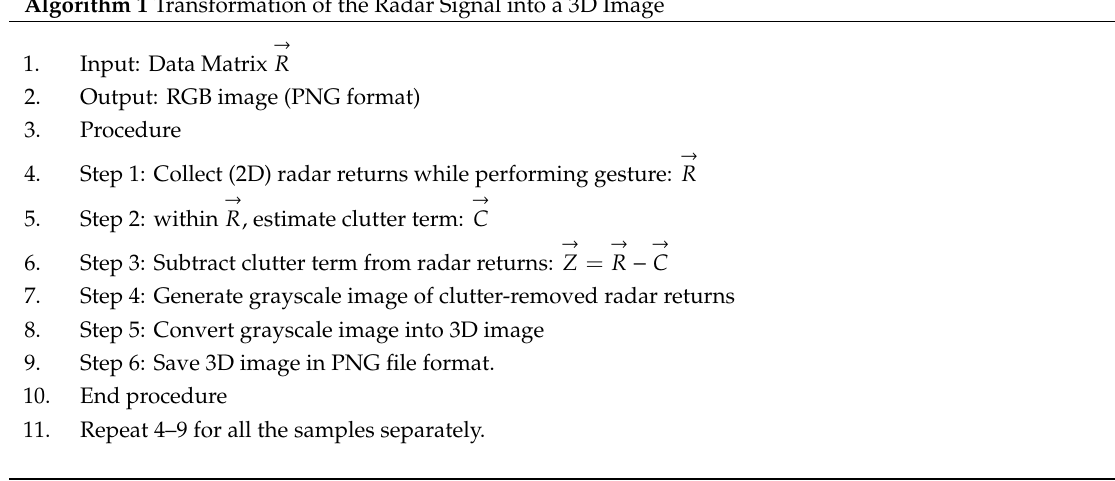
Algorithm 1 Transformation of the Radar Signal into a 3D Image